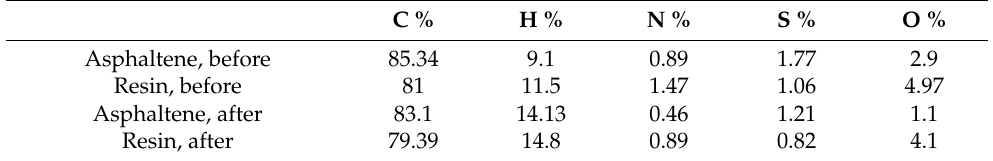
Table 7. Elemental analysis of both asphaltene and resin before and after catalytic